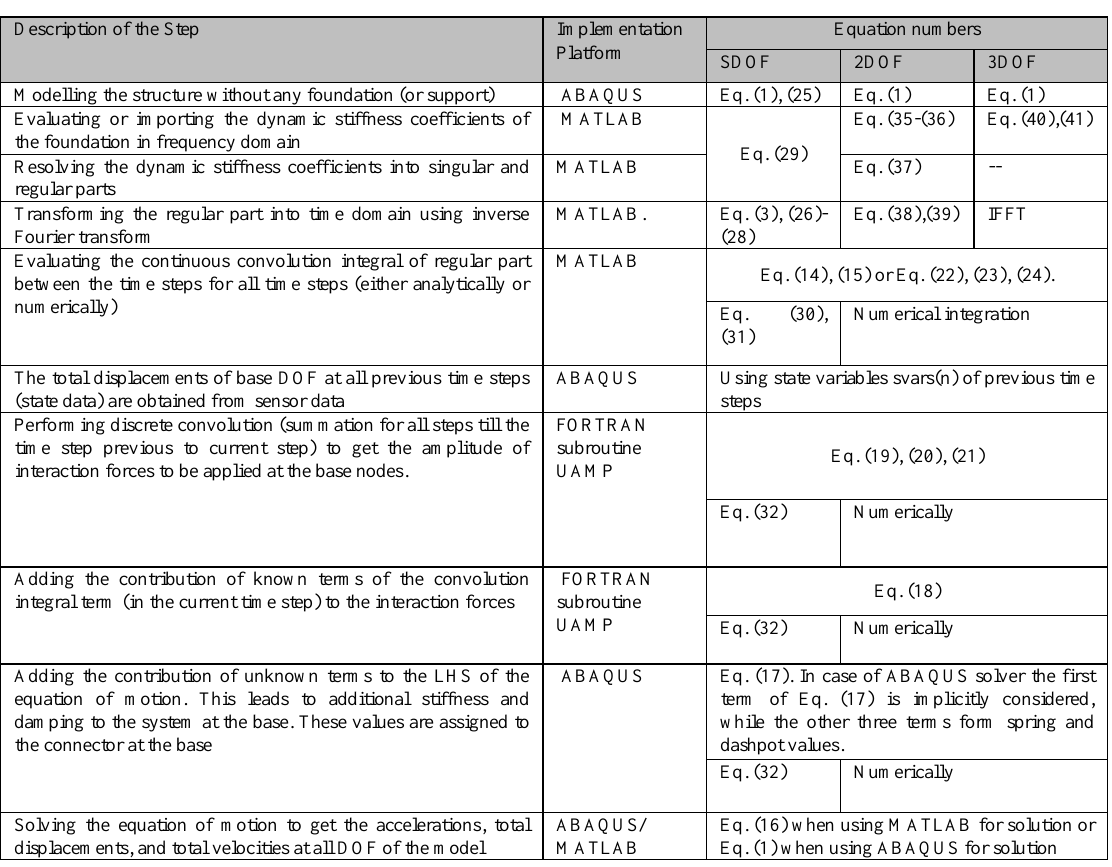
Table 1. Summary of steps involved in time domain